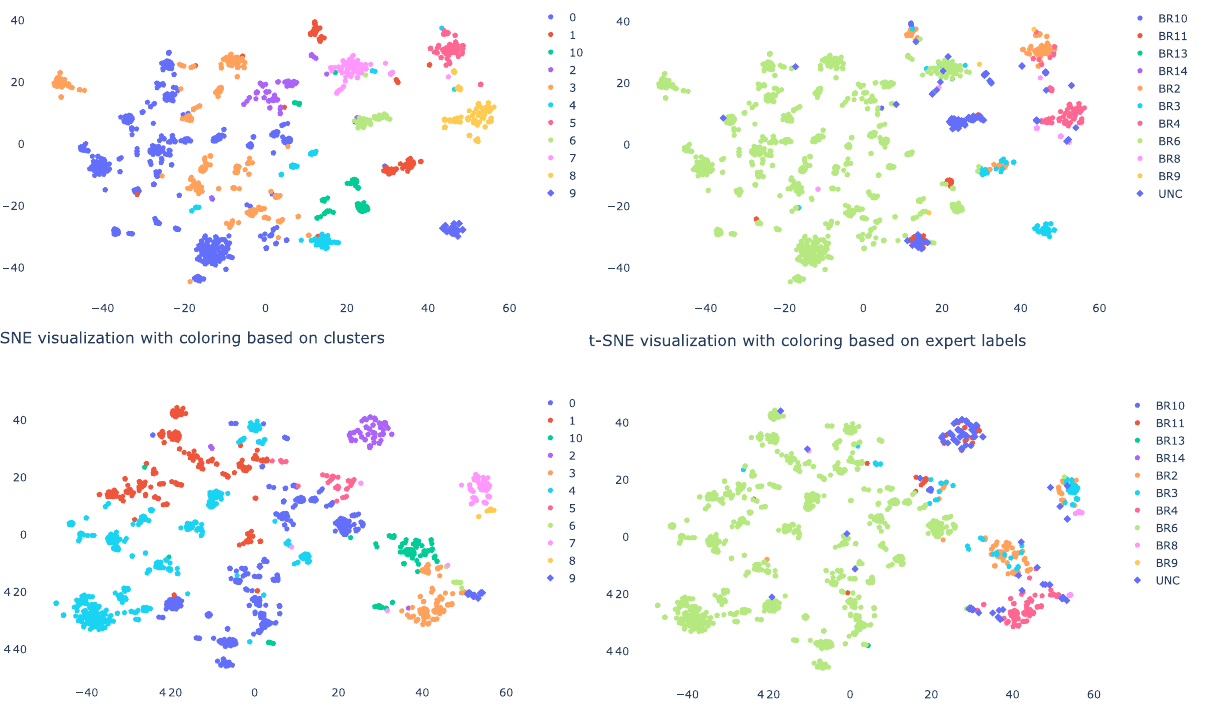
Figure 5. The t-sne visualization for company C obtained with finWalk (top) and DeepWalk (bottom), with on the left the clusters as indicated by the agglomerative clustering algorithm and on the right the expert’s